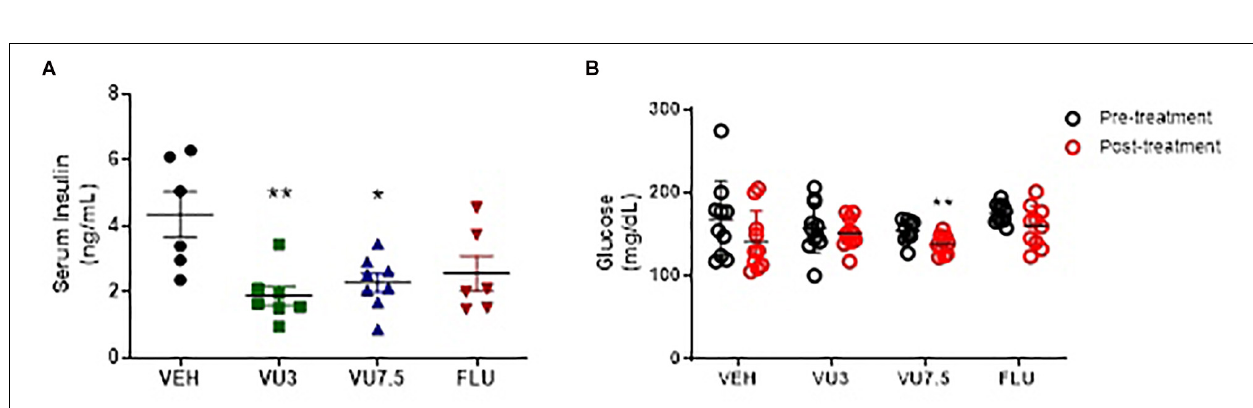
FIGURE 4 | Fourteen days’ treatment with VU0409106 reduced serum insulin and glucose levels of HFD mice. (A) Scatter plot representation of treatment with VEH (vehicle), VU0409106 (3 or 7.5 mg/kg), and fluoxetine (10 mg/kg) ( n = 7–8). * p < 0.05 and ** p < 0.01 compared to vehicle after Bonferroni multiple-comparison post hoc test. (B) Glycaemia levels of HFD mice were measured prior (pretreatment) and after 14 days drug treatment (posttreatment). Blood samples were collected after 6-h fasting. VEH (vehicle), VU0409106 (3 or 7.5 mg/kg), and fluoxetine (10 mg/kg) ( n = 10–11), ** p < 0.01 compared to vehicle after Student’s t -test.